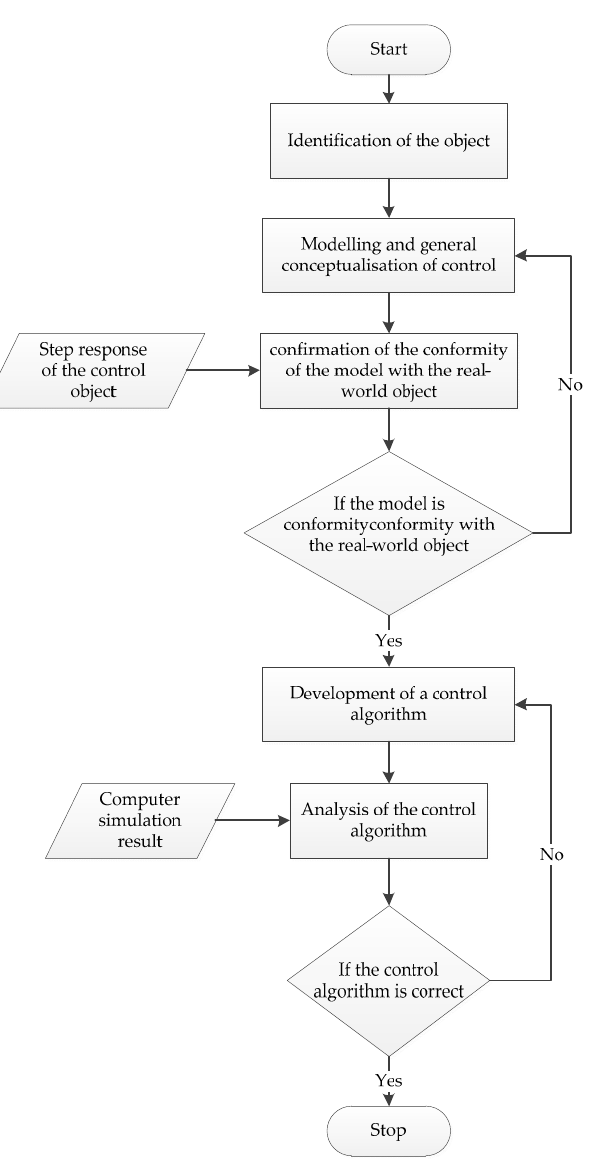
Figure 1. Iterative procedure for the optimisation of the control system as a function of limitation of energy usage in the process.